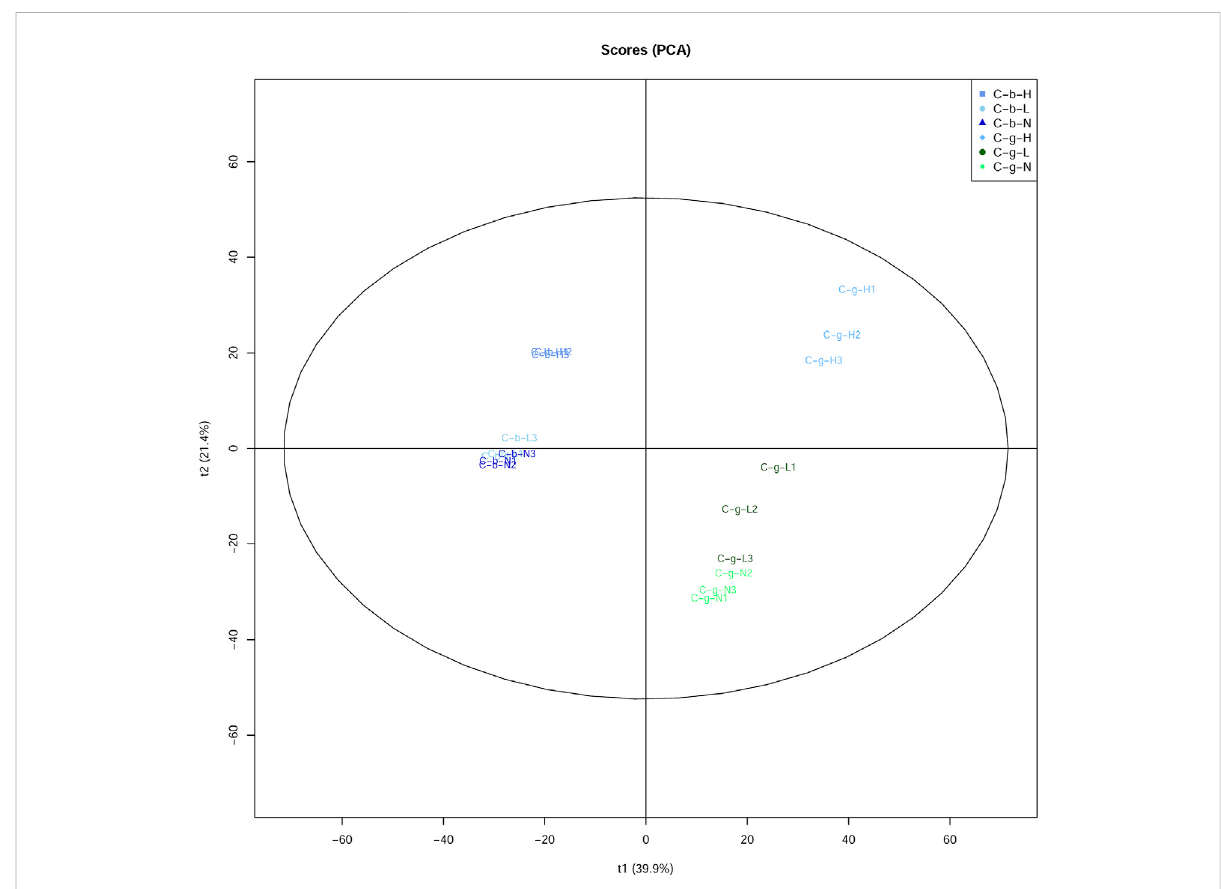
FIGURE 4 PCA analysis of DIA data among different tissues and temperatures. Note: C_b_N represents brain tissues at 22 ° C, C_b_L represents brain tissues at 4 ° C, C_b_H represents brain tissues at 30 ° C; C_g_N represents gill tissues at 22 ° C, C_g_L represents gill tissues at 4 ° C, C_g_H represents gill tissues at 30 °